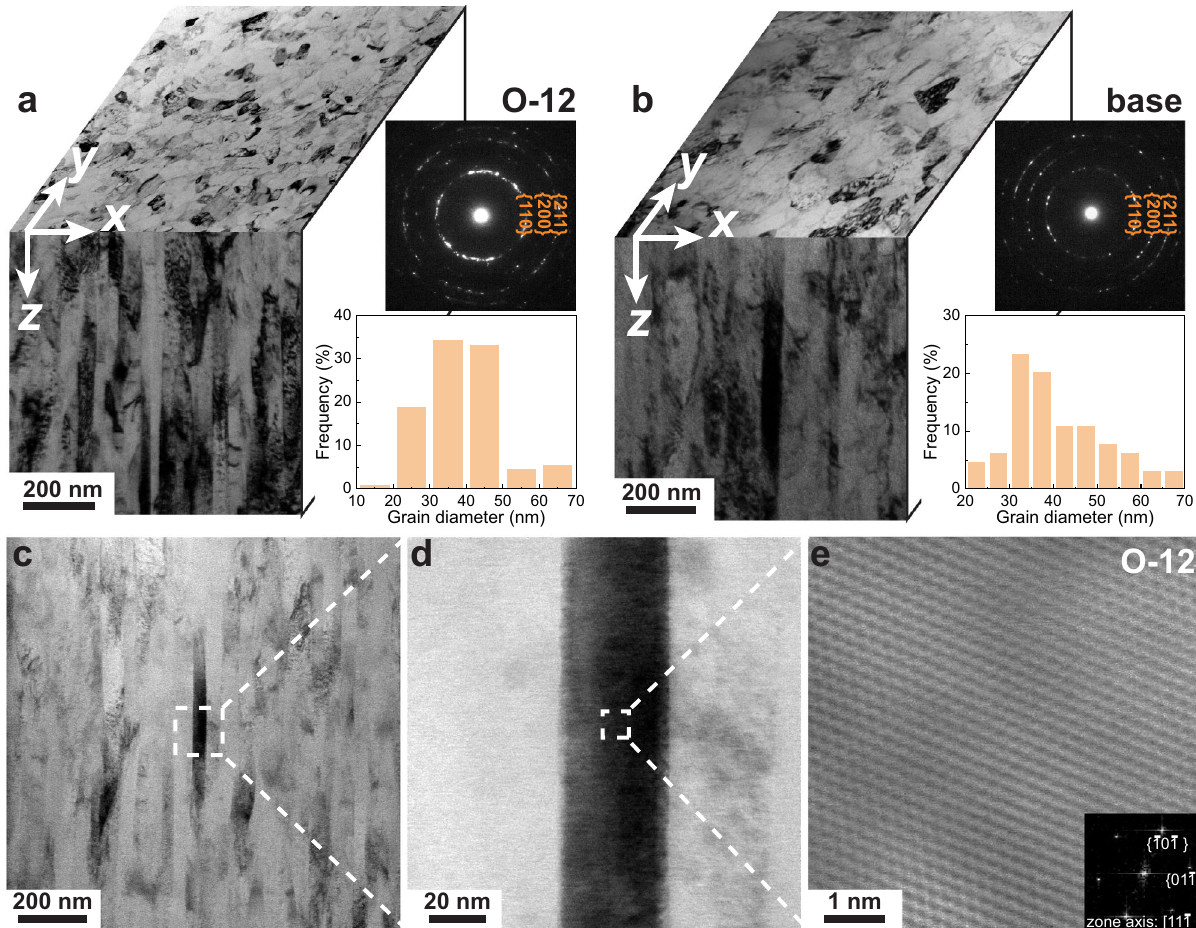
Fig. 1 Microstructures of the (TiNbZr) 86 O 12 C 1 N 1 (O-12) MISS alloy and the equiatomic TiNbZr (base) alloy. Typical side-view and in-plane-view TEM images of a the O-12 MISS alloy and b the interstitial-free base alloy, which serves here as a reference material. The x-y plane denotes the surface of the alloy and the z axis indicates the depth from the surface. The insets in a and b are the corresponding SAED patterns taken from side-view TEM specimens (top-right) and the distribution of the columnar grain diameters (bottom-right). c, d, e Annular bright- fi eld scanning transmission electron microscopy (ABF-STEM) images of the O-12 MISS alloy, showing bcc structure without oxides, carbides, or nitrides. The inset in e is the corresponding fast Fourier transformation (FFT)